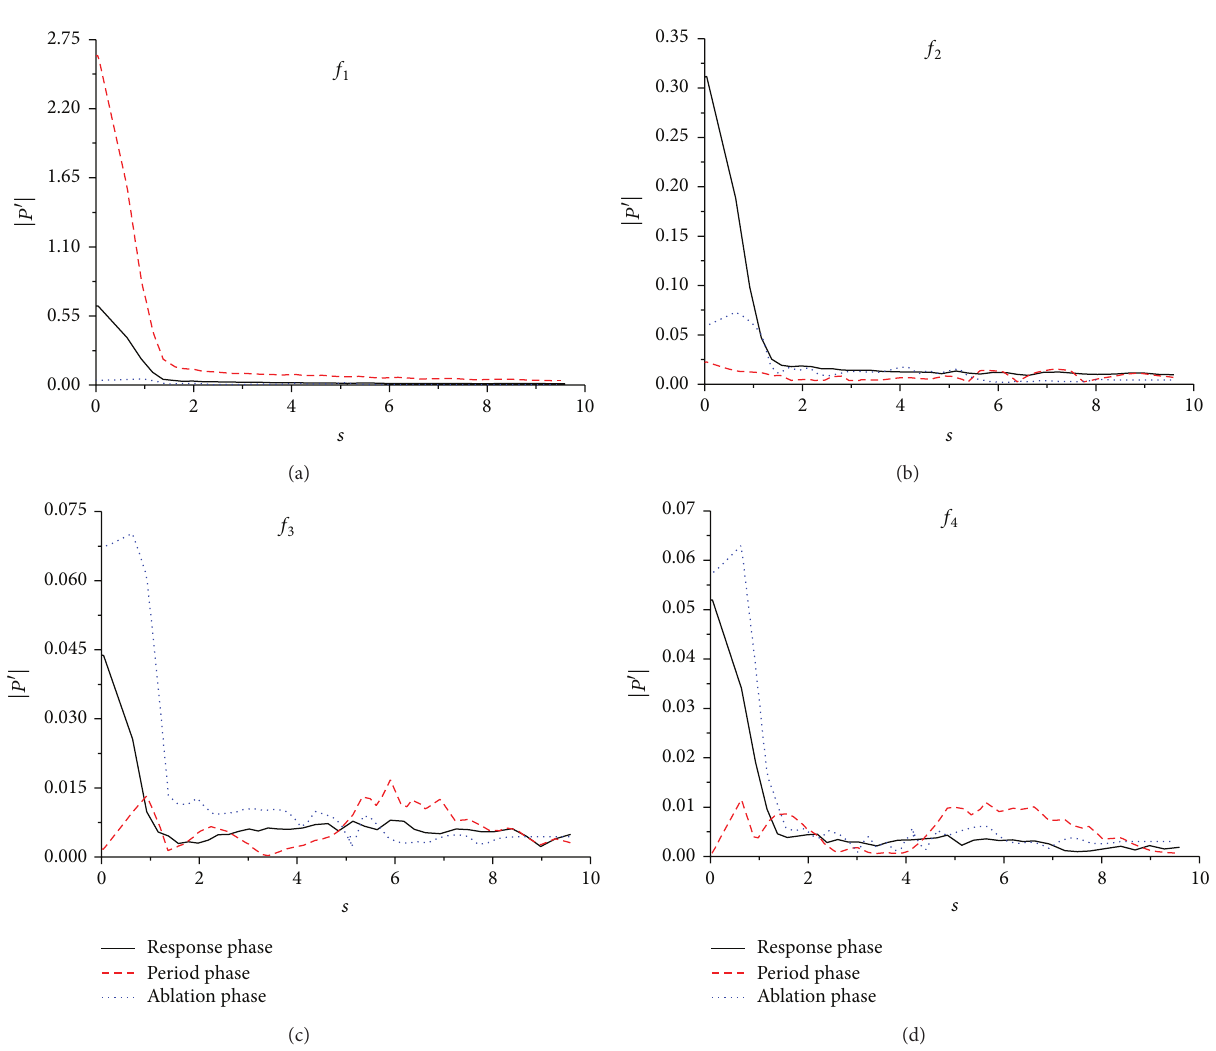
Figure 10: Comparison of pressure disturbances amplitudes in the boundary layer in 3